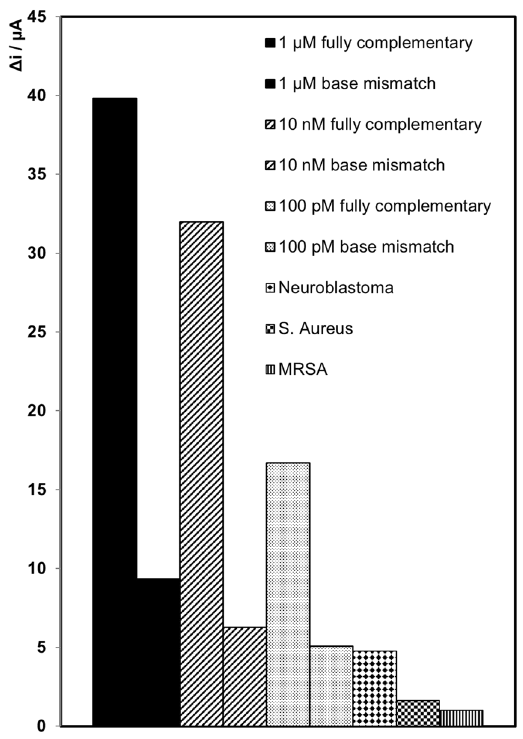
Figure 5. Comparison of the change in current for the fully complementary target strand (miR-134), the one base mismatch (miR-758) target strand and fully non-complimentary neuroblastoma (black diamonds), S. aureus (black squares), and MRSA (black vertical lines) nucleic acid strands. Three different target concentrations were used for miR-758; 1 µ M (solid black), 10 nM (black lines) and 100 pM (black dots). Concentration of the miR-132-3p, SA, and MRSA nucleic acid target strands are 1 µ M. Concentration of capture and probe miRNA strands are 1 µ M, where the probe miRNA strand is labelled with electrocatalytic PtNPs. Concentration of H 2 O 2 added is 20 µ M. Potential applied is − 0.25 V in 1 mM